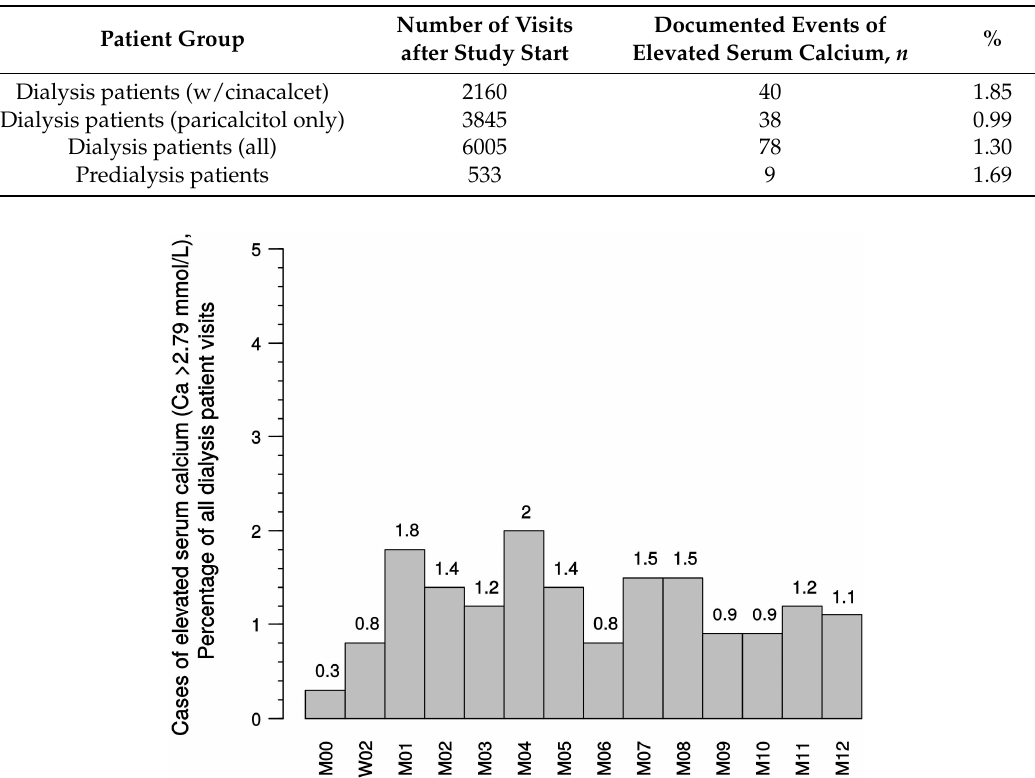
Table 15. Events of elevated serum calcium (>2.79 mmol/L) after study start.